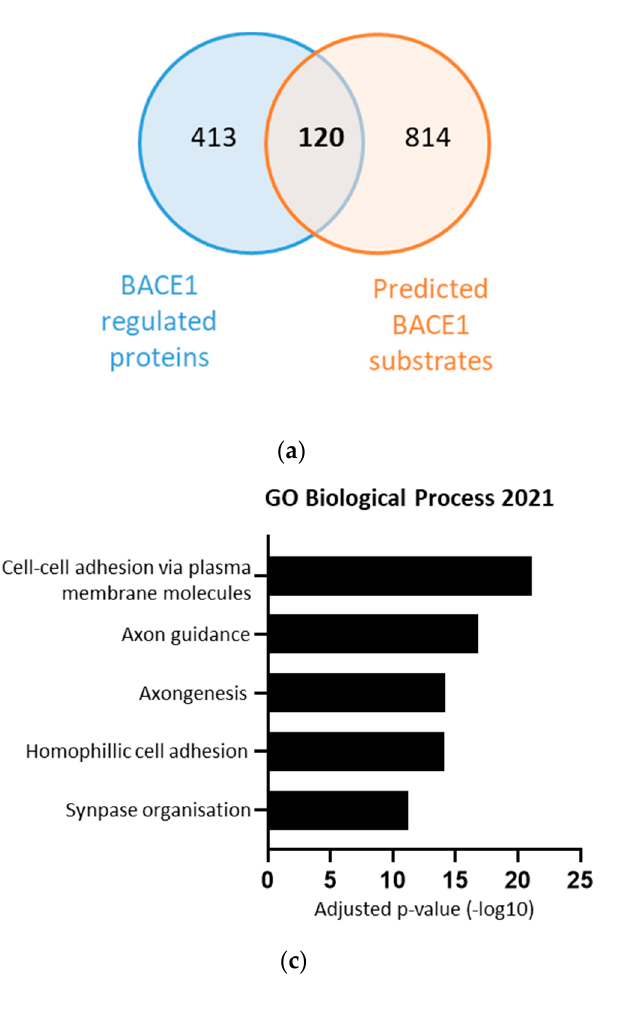
Figure 3. The 120 BACE1 substrates, identified from BACE1 experimental dependent proteins overlaid with BACE1 predicted substrates, were found to be associated with various functions including axon guidance and cell adhesion. ( a ) Venn diagram overlaying 533 experimental secreted BACE1 dependent proteins, and 934 bioinformatically predicted BACE1 substrates [37]. ( b – d ) Terms from various databases when the 120 BACE1 substrates where input into Enrichr, showing log of adjusted p -value. Table 1. The 120 BACE1 substrate list. Identified from BACE1 experimental dependent proteins overlaid with BACE1 predicted substrate [37]. Validated and well characterised substrates are shown in red. The table is shaded grey where three or more members of the same family were found.